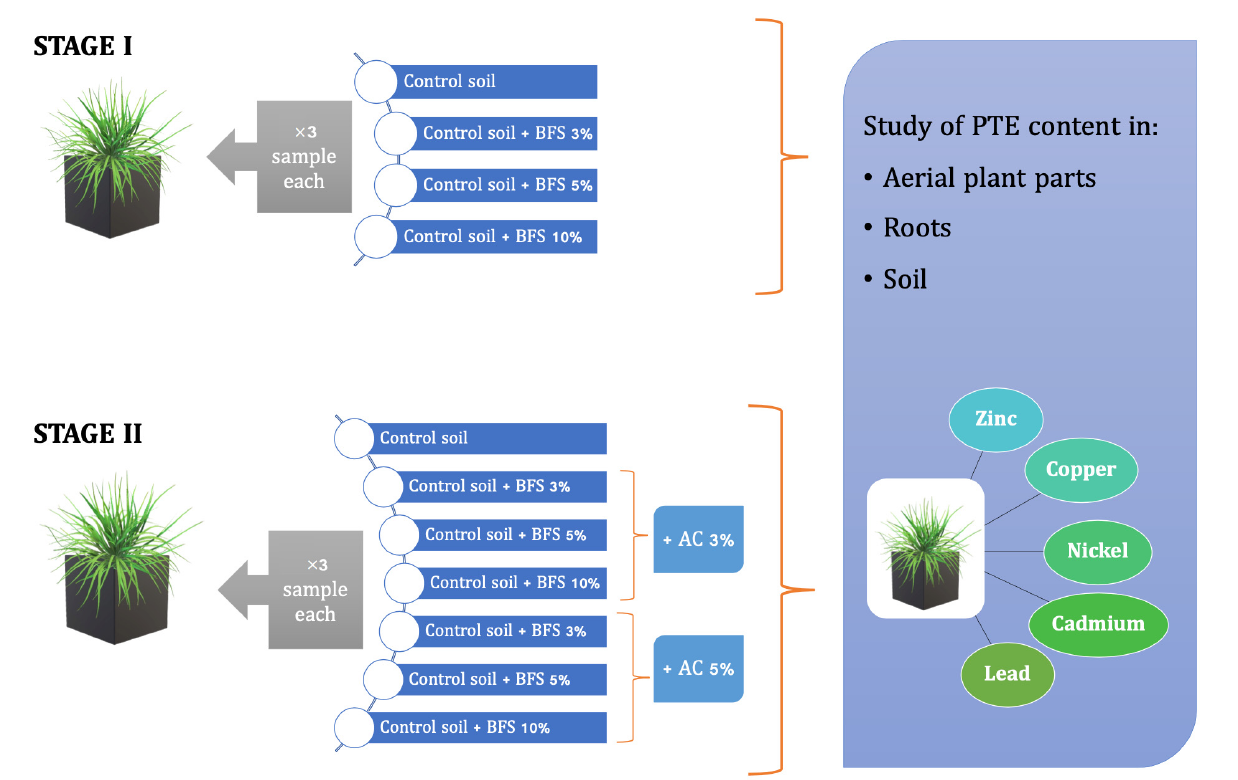
Figure 3. Diagram of the research performed.